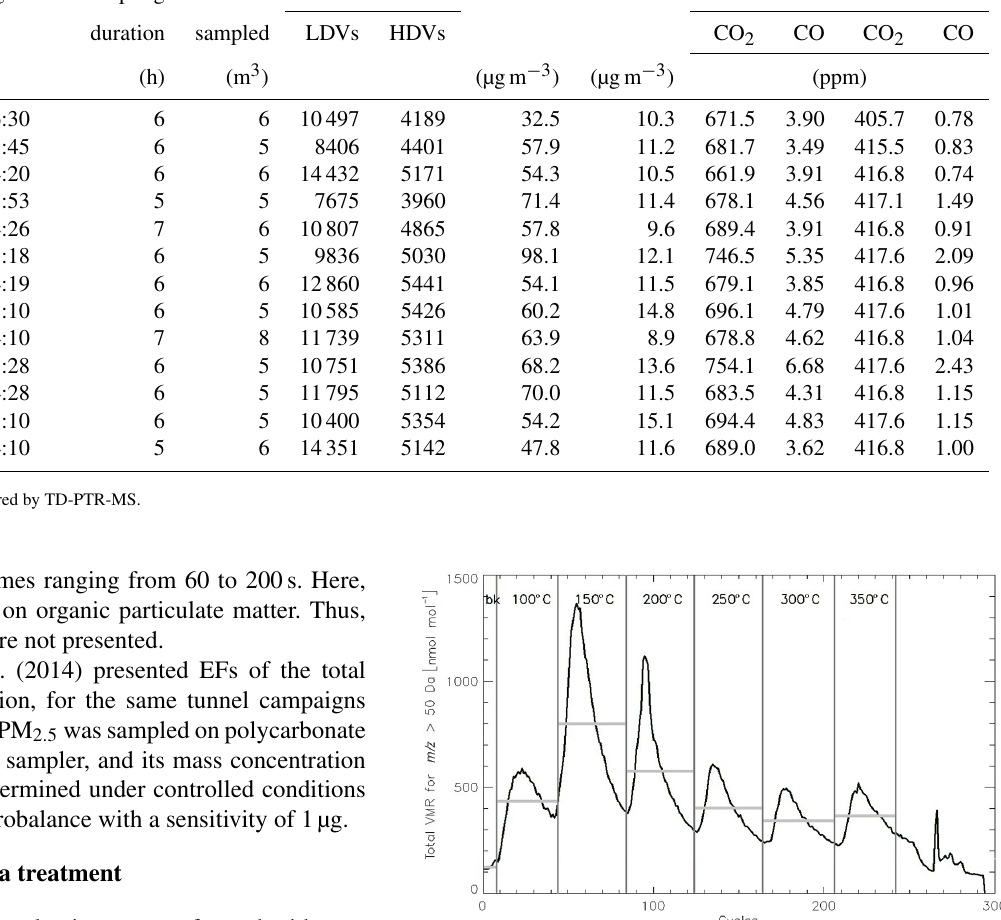
Table 2. Filter identification number, sampling start time, sampling duration, volume sampled for OA samples, vehicle counts, OC and OA concentrations, and average CO 2 and CO concentrations during sampling inside and outside of the TRA tunnel during 2011. Filter no.